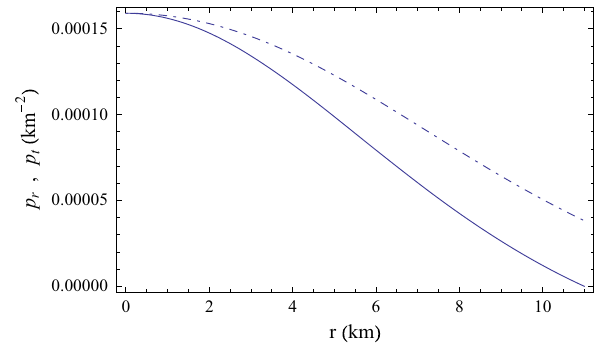
Fig. 5 Variation of p r (solid line) and p t (dot dashed) with r of PSR J0348+0432 for β = 1 (considering α = 0 . 4)